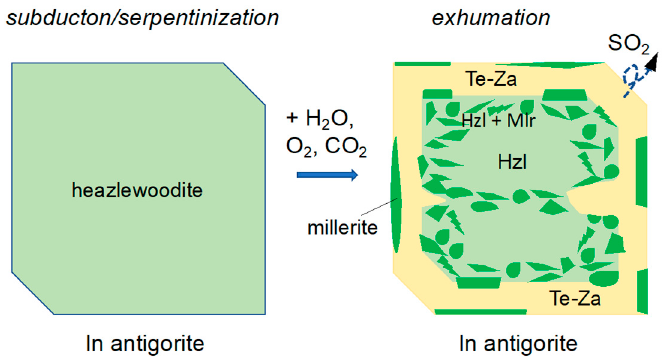
Figure 8. Schematic illustration of the process of desulfurization of heazlewoodite. The metamorphic heazlewoodite (Hzl, Ni 3 S 2 ; pale green) has been decomposed to millerite (Mlr, NiS; green) and theophrastite [Te, Ni(OH) 2 ] and zaratite [Za, Ni 3 (CO 3 )(OH) 4 · 4H 2 O)] (dark yellow) during/after exhumation of the complex.